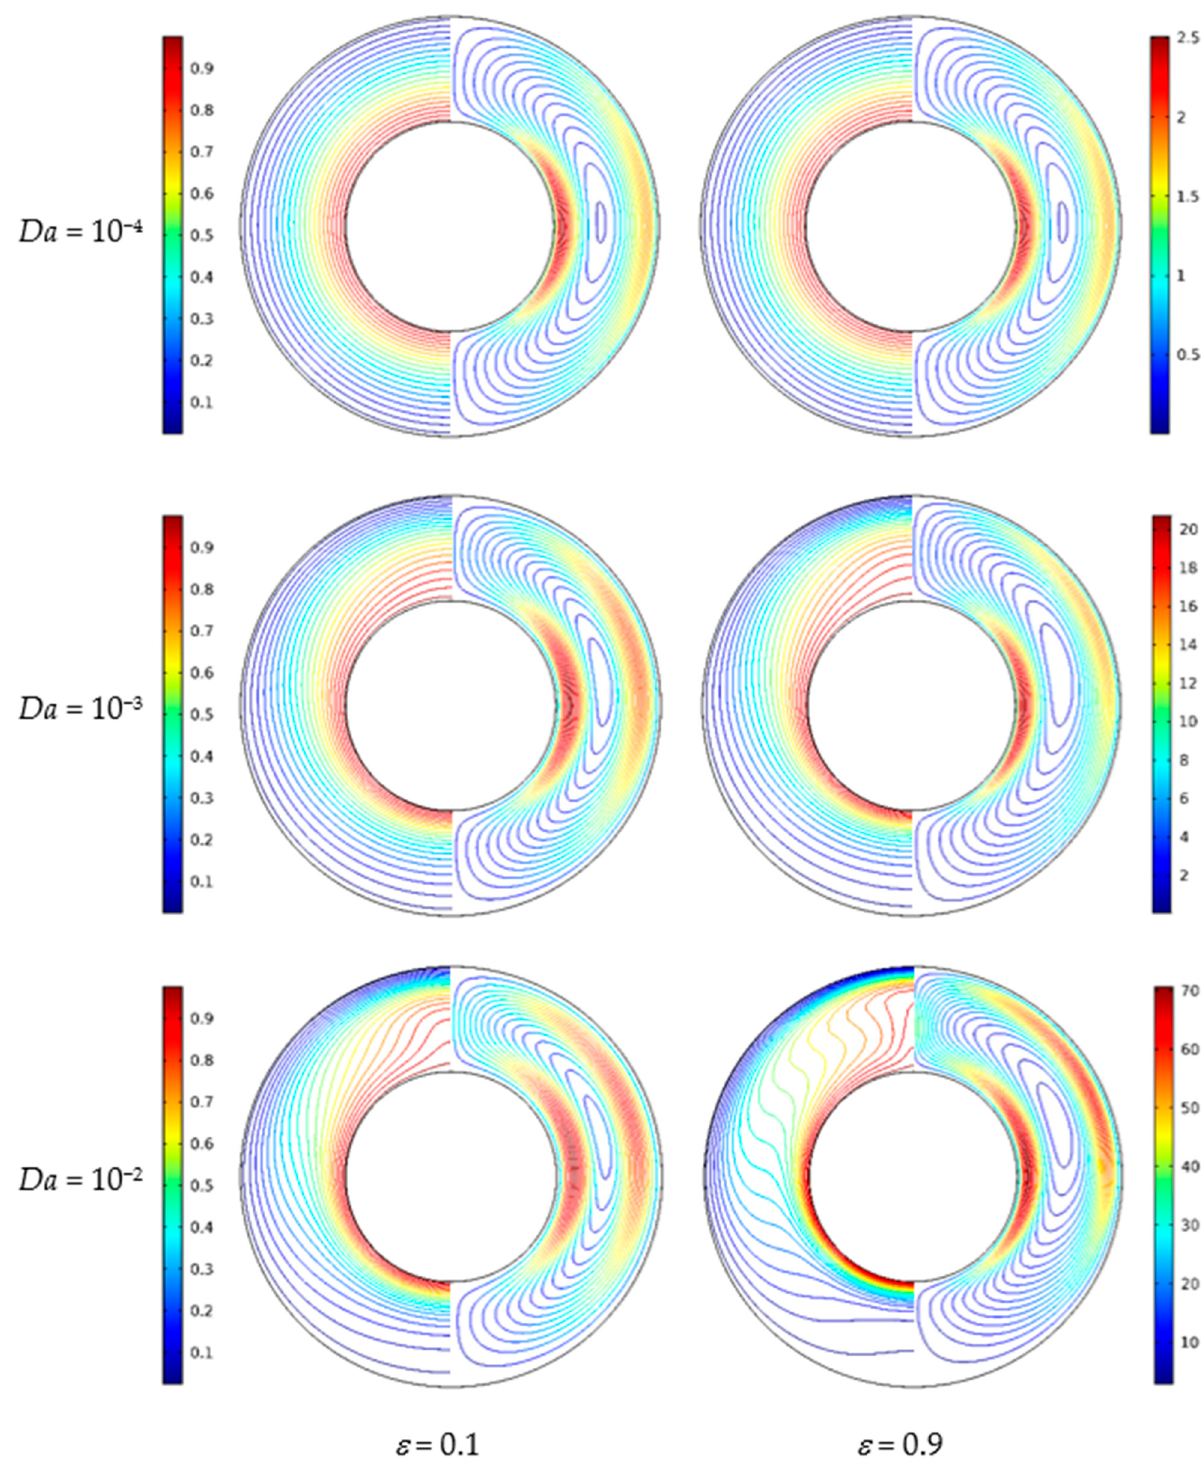
Figure 16. Isotherms (left) and streamlines (right) for Cu–water nanofluid for different porosity ( ε ) and Darcy numbers ( Da ) at Ra = 5 × 10 4 , ϕ = 0.05, d sp = 50 nm, and RR = 2.